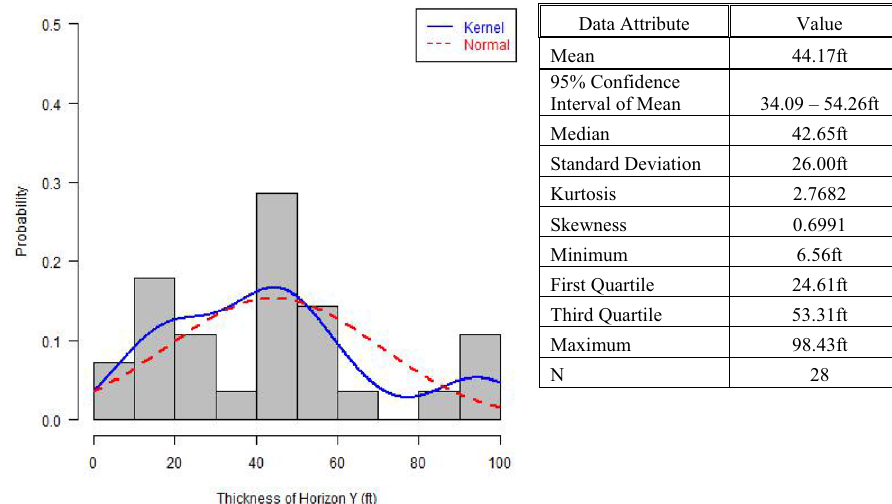
Fig. 23 Descriptive statistics and distributions of thickness of Horizon